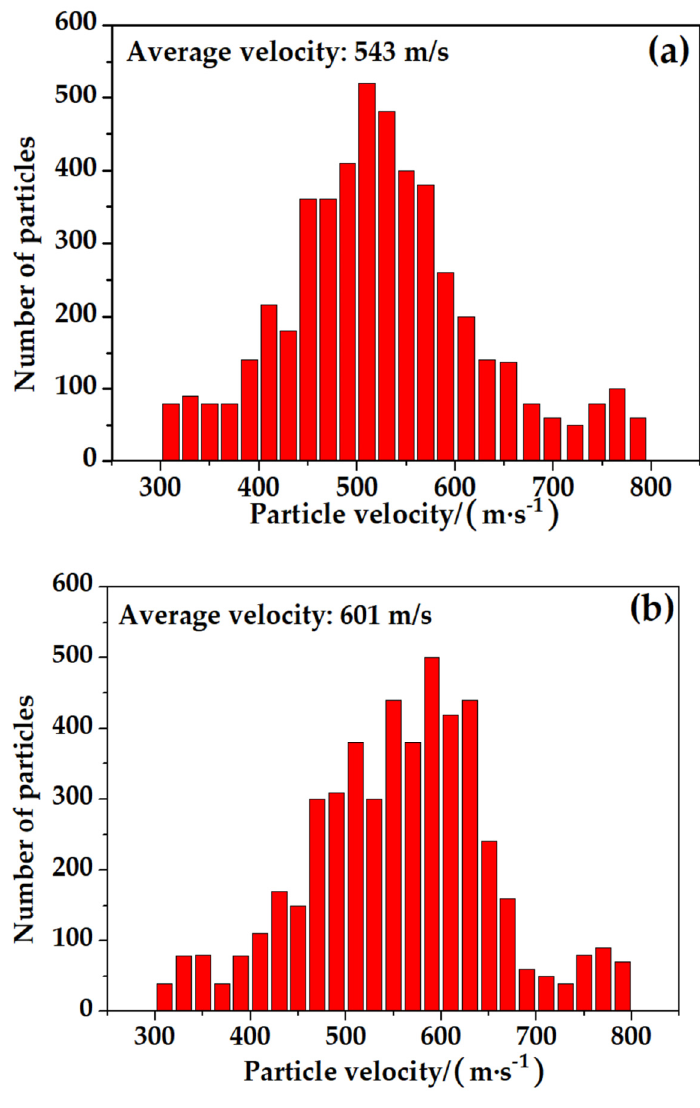
Figure 6. Velocity distribution of Ni-coated Al particles at an accelerating gas temperature of ( a ) 200 ◦ °C and ( b ) 400 °C. and ( b ) 400